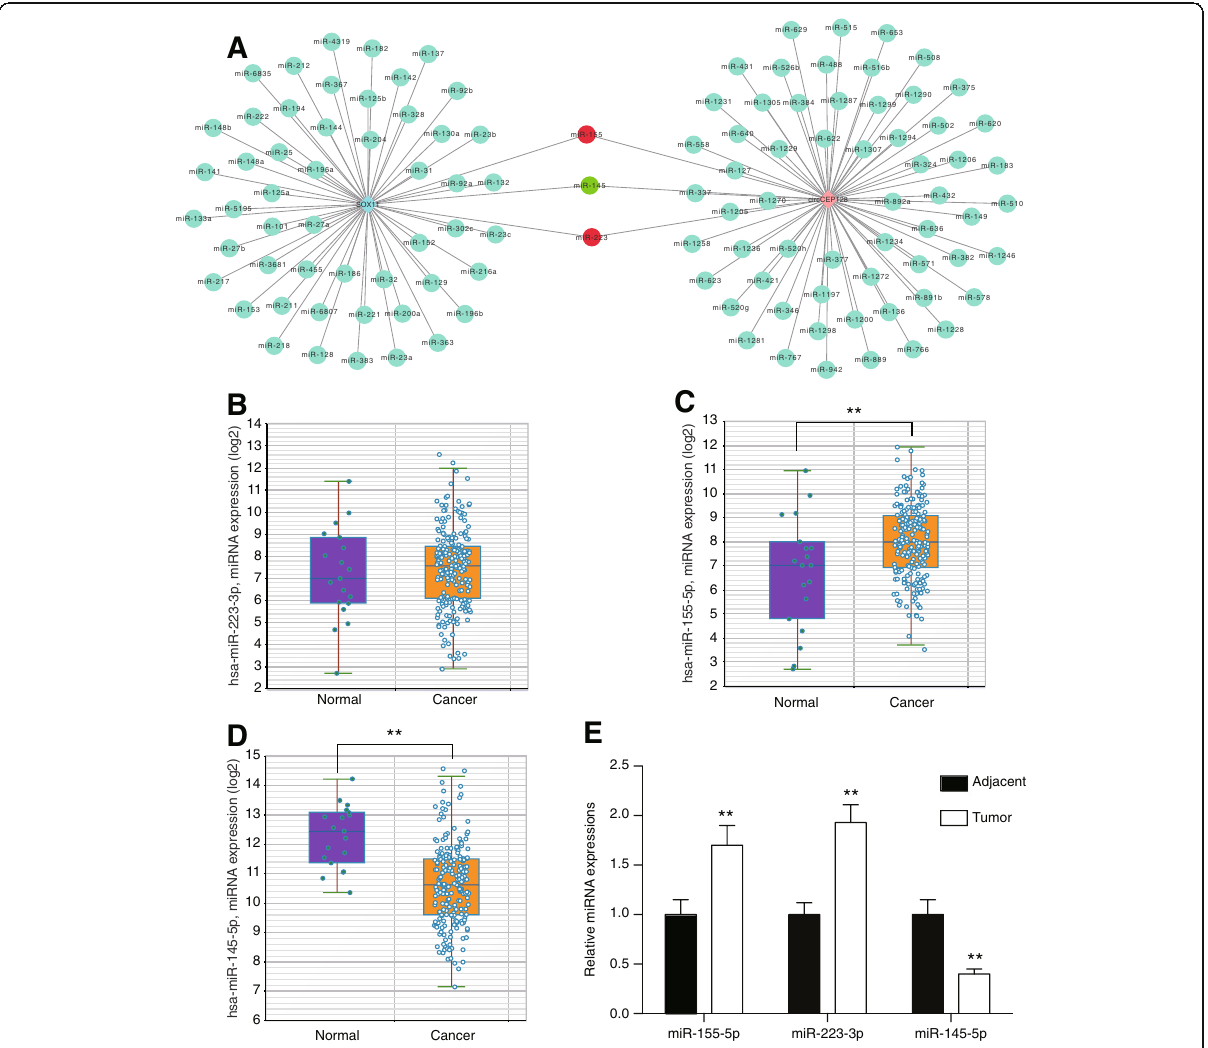
Fig. 2 CeRNA analysis for circCEP128. a Cytoscope was used to visualize circCEP128-miRNA-target gene interactions based on the TargetScan and circular RNA interactome. Red color indicates high expression level in bladder cancer and green color indicates low expression level in bladder cancer. b-d TCGA bladder cancer patients ’ data analysis was that miR-223-3p expression had no significant difference, miR-155-5p expression increased but miR-145-5p expression decreased in tumor samples. ** P <0.01, compared with adjacent samples. e QRT-PCR results showed that miR-155 and miR-223 was up-regulated in tumor tissues while miR-145 was down-regulated in tumor tissues. ** P <0.01, compared with adjacent